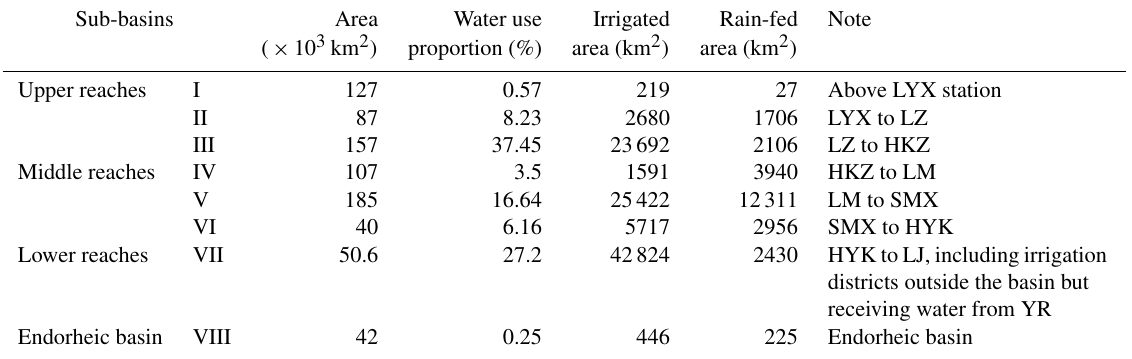
Table 1. The eight sub-basins of the Yellow River (YR) basin. Sub-basins